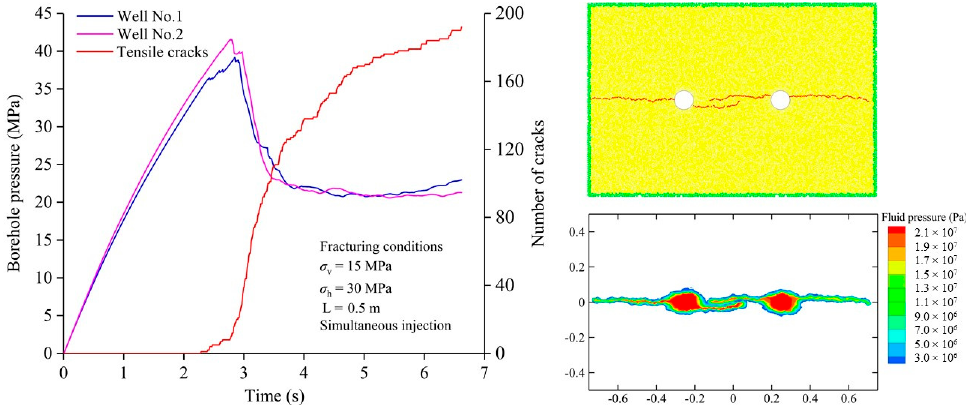
Figure 12. The borehole pressure histories, crack spatial distribution and corresponding fluid pressure field in the simultaneous fracturing under the in-situ differential stress condition ( σ v = 15 MPa and σ h = 30 MPa).